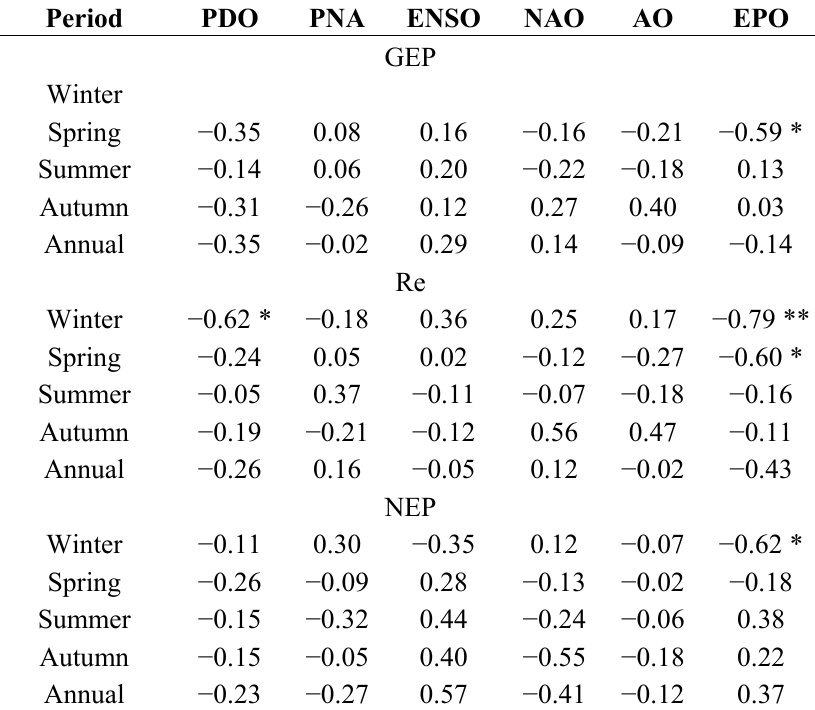
PDO: the Pacific Decadal Oscillation; PNA: the Pacific-North American; ENSO: El Niño-Southern Oscillation; NAO: North Atlantic Oscillation; AO: Arctic Oscillation; EPO: Eastern Pacific Oscillation. *